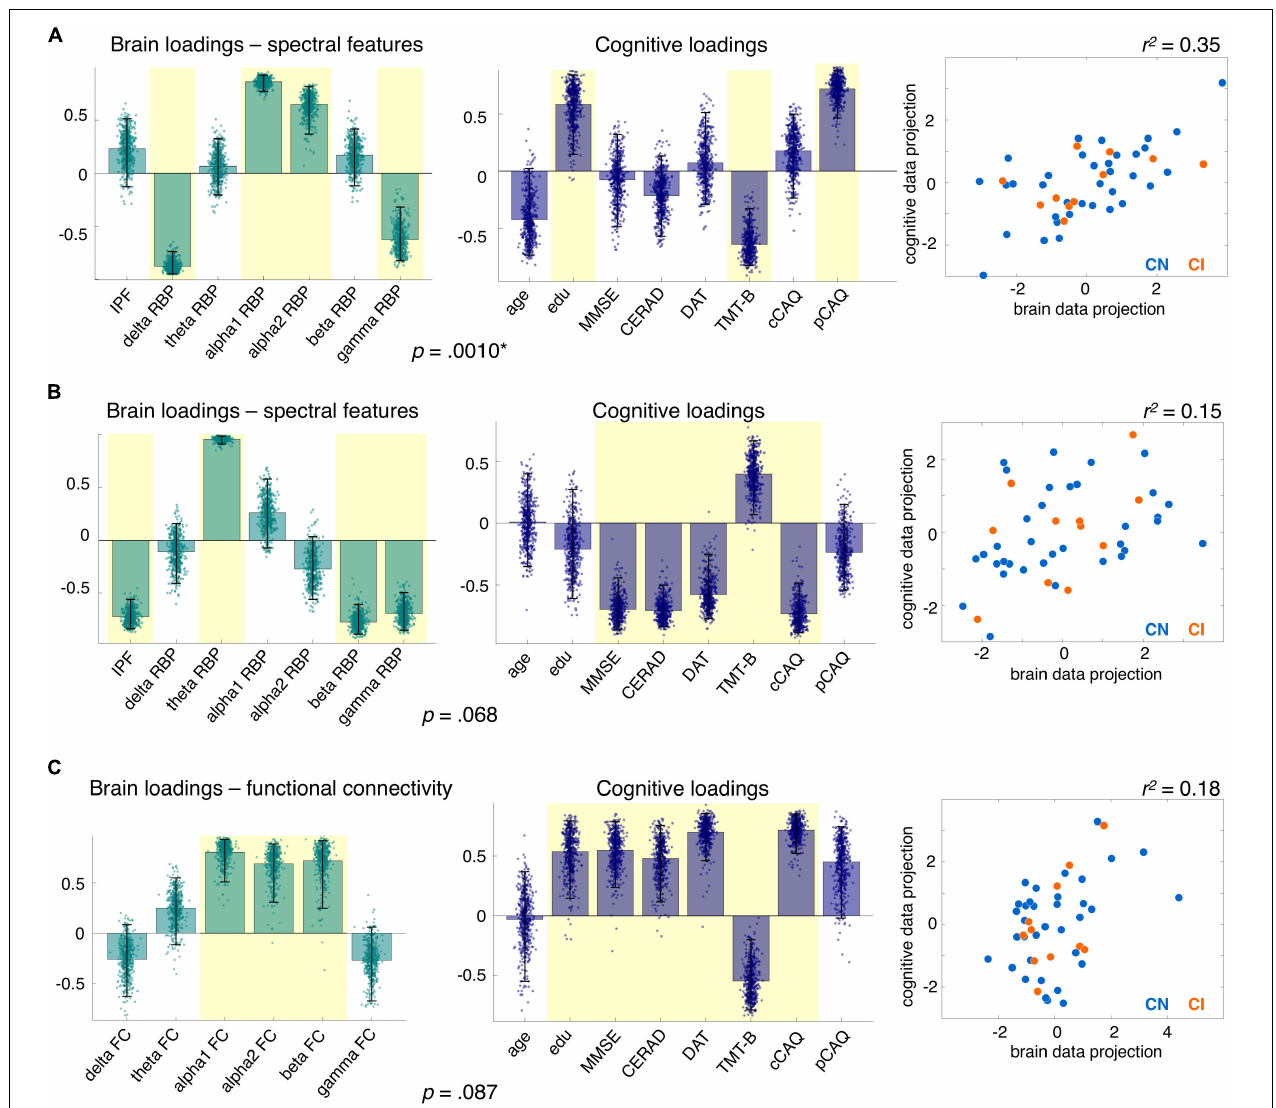
FIGURE 4 | Multivariate correlation patterns between electrophysiological and cognitive features. Each panel represents, from left to right: (i) the brain loadings, (ii) the cognitive loadings, and (iii) the data projection onto the brain and cognitive saliences for the first (A) and second (B) significant multivariate correlation patterns between spectral and cognitive features, and for the multivariate pattern between functional connectivity and cognitive features (C) from partial least square correlation (PLSC) analyses. In the loading plots, bars and dots represent the average and dispersion of brain and cognitive loadings over 500 bootstraps; loadings reliably different from zero are shaded in yellow. P -values for the multivariate correlation patterns are reported below the loading bar plots (* indicates pattern surviving multiple comparison correction at FDR < 0.05). In the scatter plots on the right, each dot represents brain and cognitive data of a single subject projected onto the corresponding PLSC saliences, with cognitively normal (CN) and impaired (CI) subjects represented in light blue and orange, respectively. The r-squared between the brain and cognitive data projection onto the PLSC saliences is reported above each scatter plot and quantifies the amount of cognitive scores’ variance explained by the spectral or functional connectivity